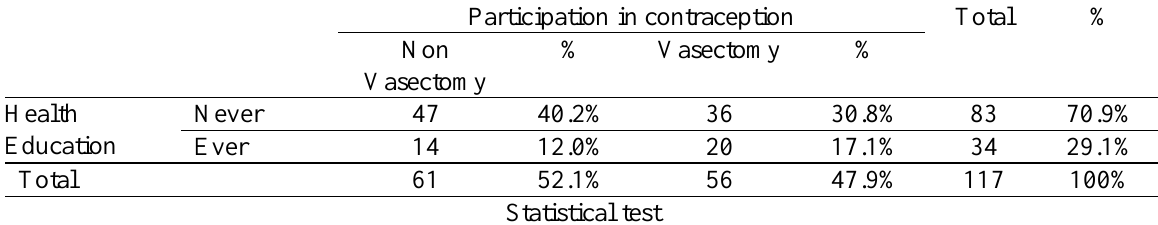
Table 6 The correlation of health education with vasectomy